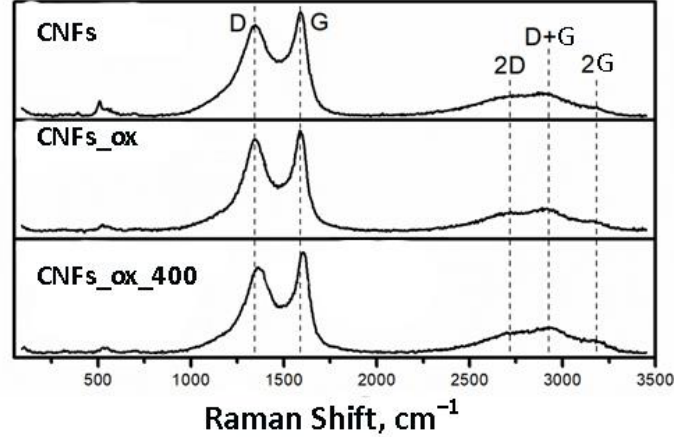
Figure 2. The Raman spectra of GNFs, GNFs_ox, and GNFs_ox_400. The state and content of the oxygen and carbon were analyzed by XPS (Figure 3a). The oxygen content in the GNFs was equal to 0.7 at. % [30]. The total oxygen content in the GNFs_ox was 11.1 at. %. During the heat treatment of the GNFs_ox at 400 ◦ C, portions of the functional groups were eliminated and the oxygen content decreased to 6.5 at.